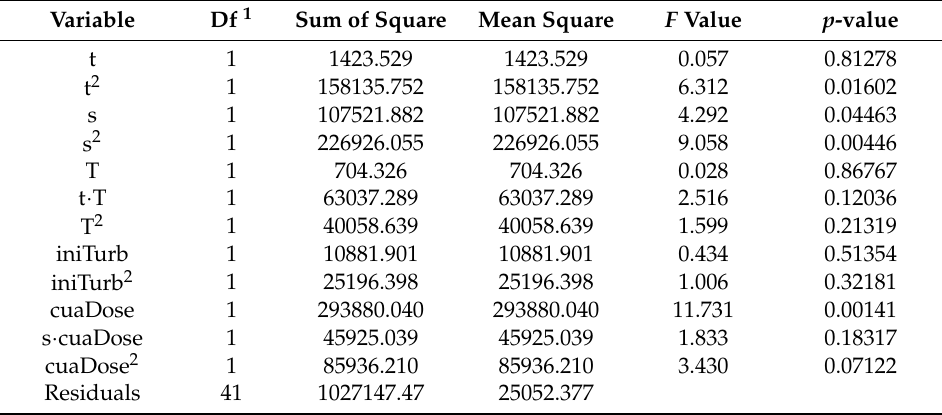
Table 10. ANOVA values for the “TSS” quadratic model for ECOTAN BIO